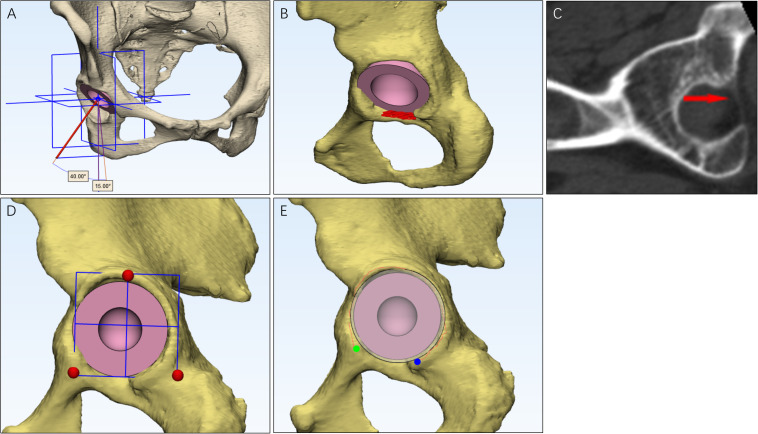
The methods to use the four cup positioning guides. For the mechanical alignment guide (A), inclination was the angle between the cup axis and the sagittal plane, and the anteversion was the angle between the longitude axis and the cup axis that was projected to the sagittal plane. For transverse acetabular ligament guide (B), the face of the cup was placed parallel to the transverse acetabular ligament, and the face was attached to the inner edge of the transverse acetabular ligament, which could be observed in CT (C). When using the ischiadic-pubis line guide (D), the face of the cup was paralleled to a plane that was consisted of three points, including the lowest point of the acetabular sulcus of the ischium, the prominence of the superior pelvic ramus, and the most superior point of the acetabular rim. When using acetabular rim labrum guide (E), the face of the cup was paralleled to the plane that is fit to the labrum around the acetabular rim.